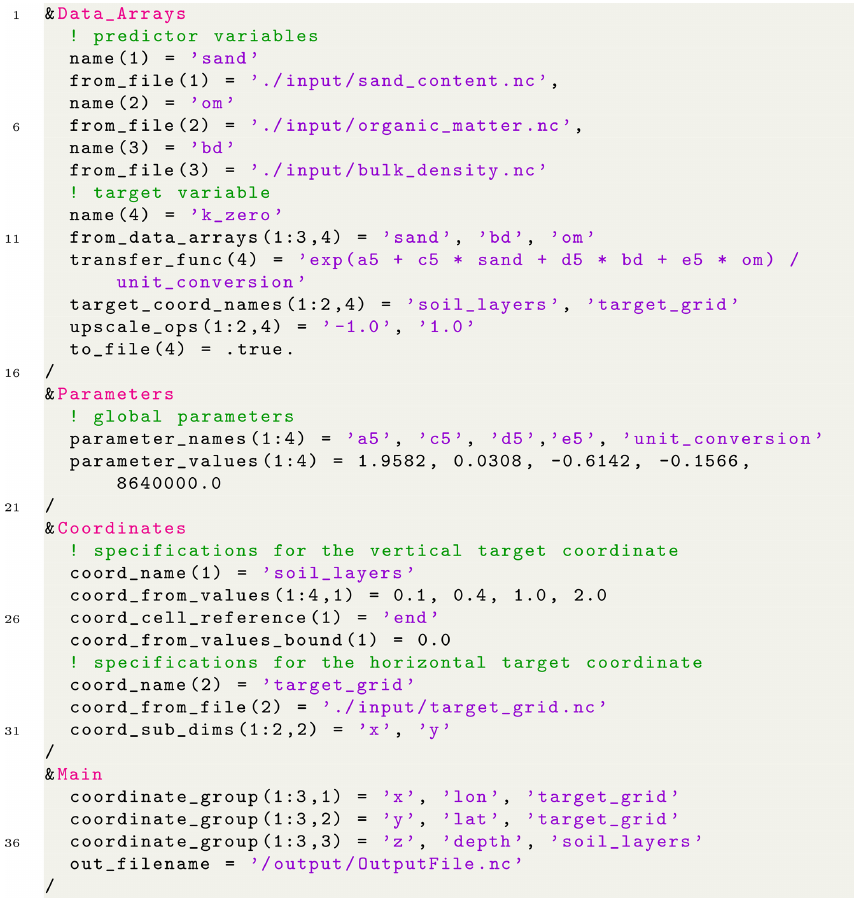
Figure 2. Example mpr.nml file for calculating k 0 for the R02B05 ICON grid following Weynants et al. (2009) using the SoilGrids (Hengl et al., 2017)